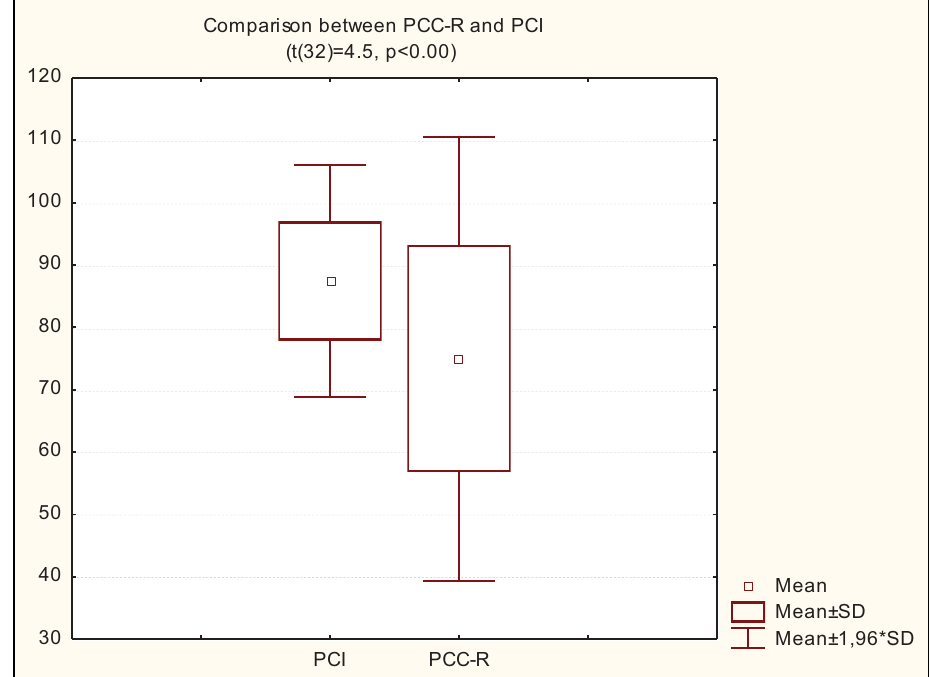
Figure 2: Boxplot of comparison between speech production and speech perception perfor- mances.